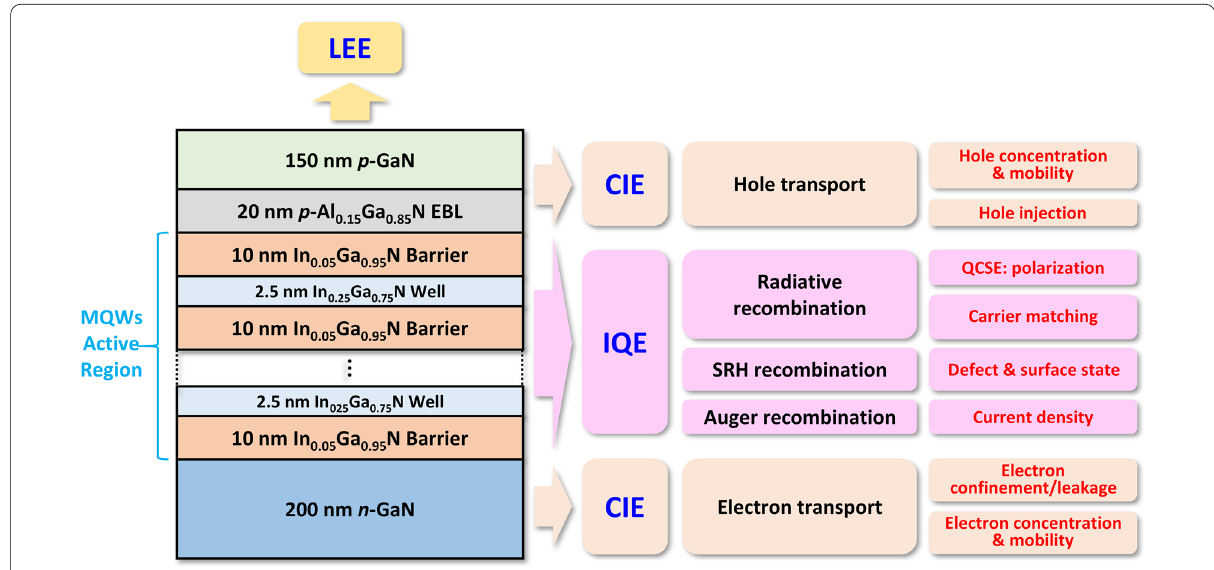
Fig. 1 Schematic illustration of the InGaN/GaN-based blue light-emitting-diode used for the simulation and the analysis of efficiency for